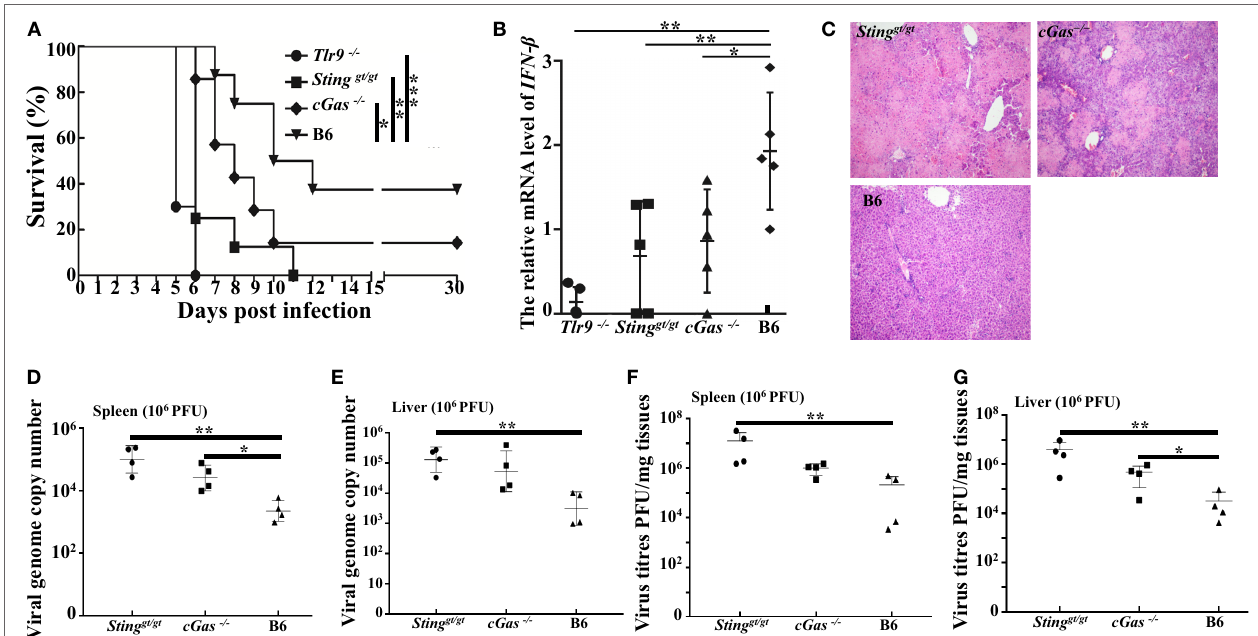
FigUre 8 | Tlr9, Sting, and cGas are critical for resistance to ectromelia virus (ECTV) at a high infection dose. Sting gt/gt , cGas − / − , Tlr9 − / − , and wild-type (WT) mice (B6) were infected with 1 × 10 6 plaque-forming units (PFUs) of ECTV in the left footpad. (a) Mice were monitored twice daily over 30 d for survival. (B) Expression of IFN- β in the spleens of the indicated mice at 3 days post-infection (dpi) was examined by qPCR. (c) Liver sections of the indicated mice at 7 dpi were stained with hematoxylin and eosin. (D–g) The spleen and liver from infected mice were harvested at 7 dpi, and then viral genome copy numbers (D , e) and viral loads (F , g) were determined by qPCR and plaque assay, respectively. Statistical analyses were performed by one-way analysis of variance followed by the Duncan’s multiple range test. For survival experiments, we used the log-rank (Mantel–Cox). In this figure, ns, not significant; * P ≤ 0.05; ** P ≤ 0.01; and *** P ≤